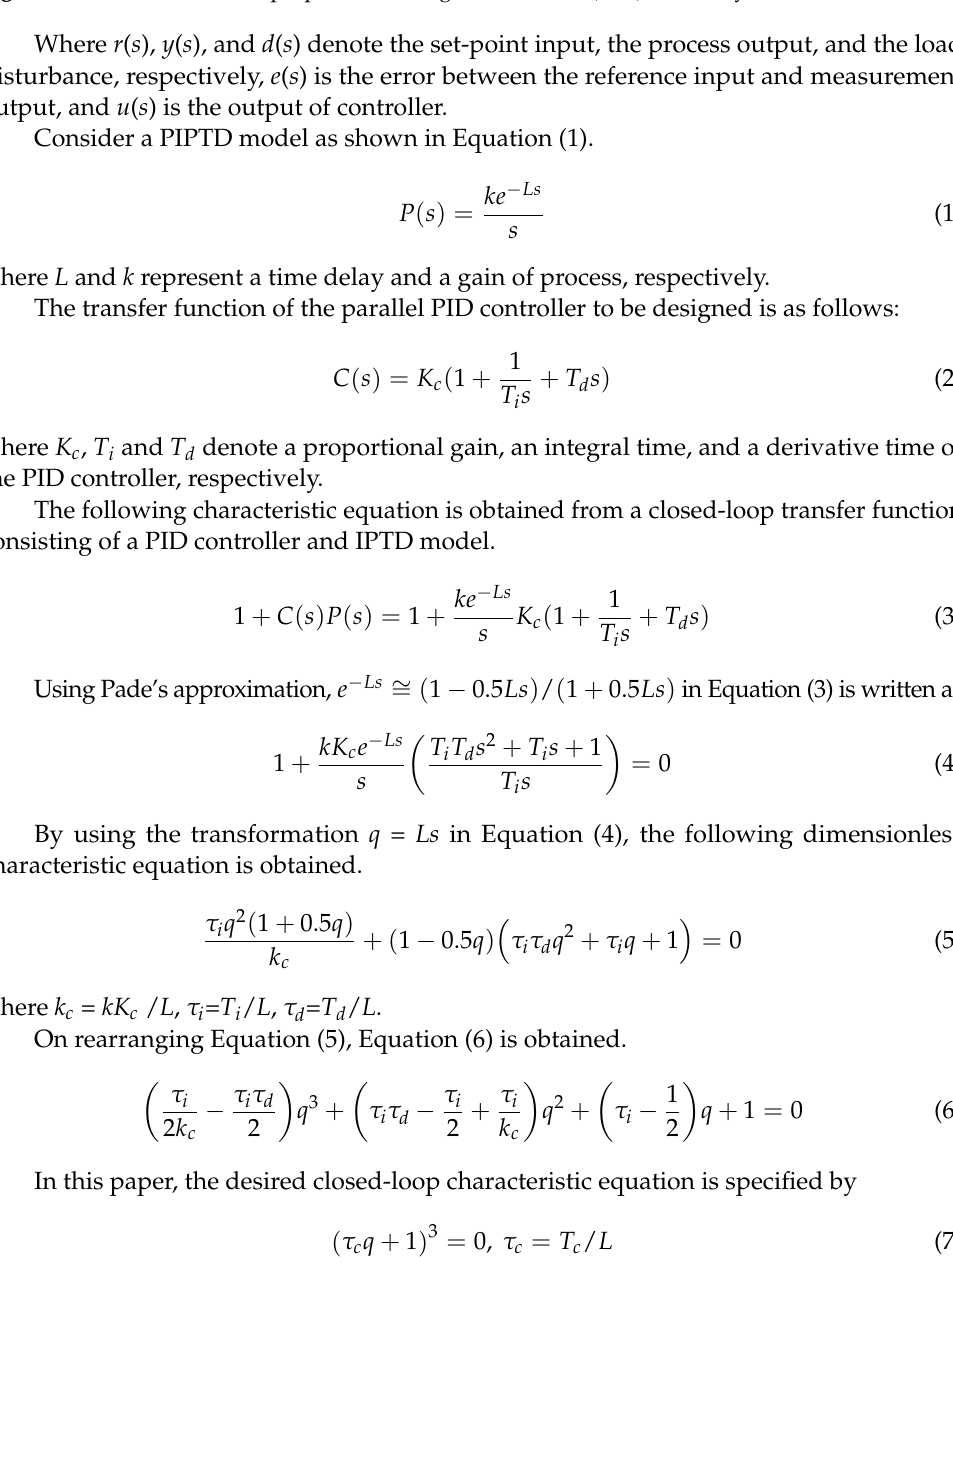
Figure 1. Structure of a basic proportional integral derivative (PID) control system.